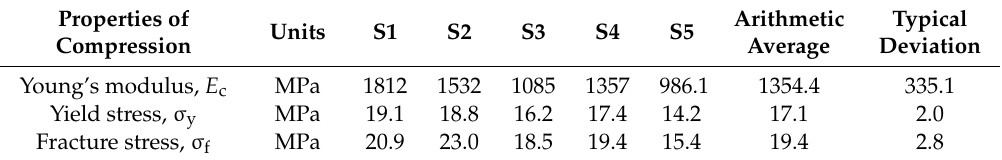
Table 8. Elastic and mechanical properties of Nylstrong GF–PA6 for each X-axis